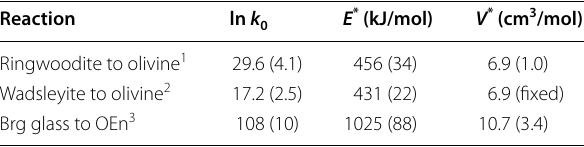
The uncertainties in kinetic parameters are listed in parentheses 1 Equation (3) was fitted to the growth rate data obtained in this study 2 Equation (3) was fitted to the growth rate data obtained in Reynard et al. (1996) and Hu and Sharp (2017) assuming the same activation volume as that of the ringwoodite to olivine transformation 3 Equation (4) was fitted to the rate constant k data obtained in this